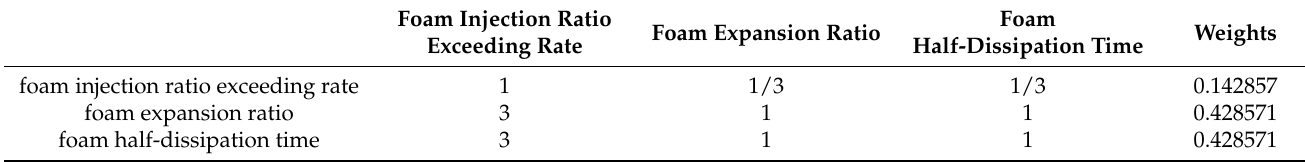
Table A8. Pairwise comparison matrix for quaternary level soil conditioning operational